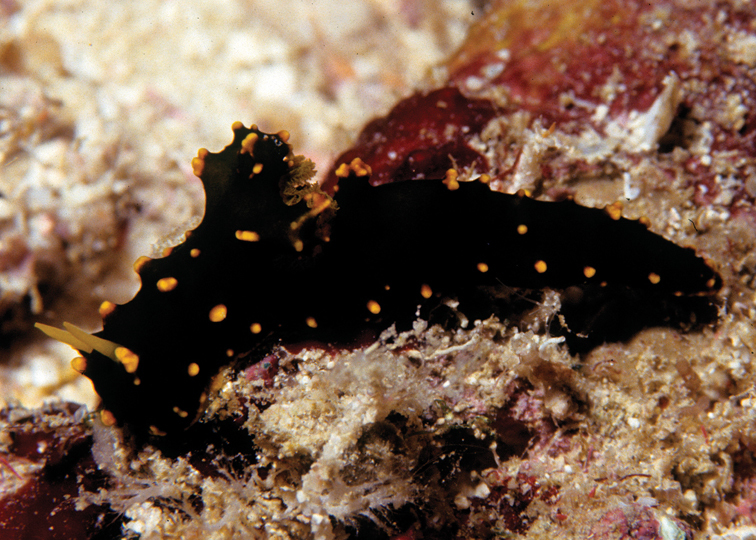
Notodoris gardineri form nigerrima, 40 mm, Maldives, photo: RC Anderson.